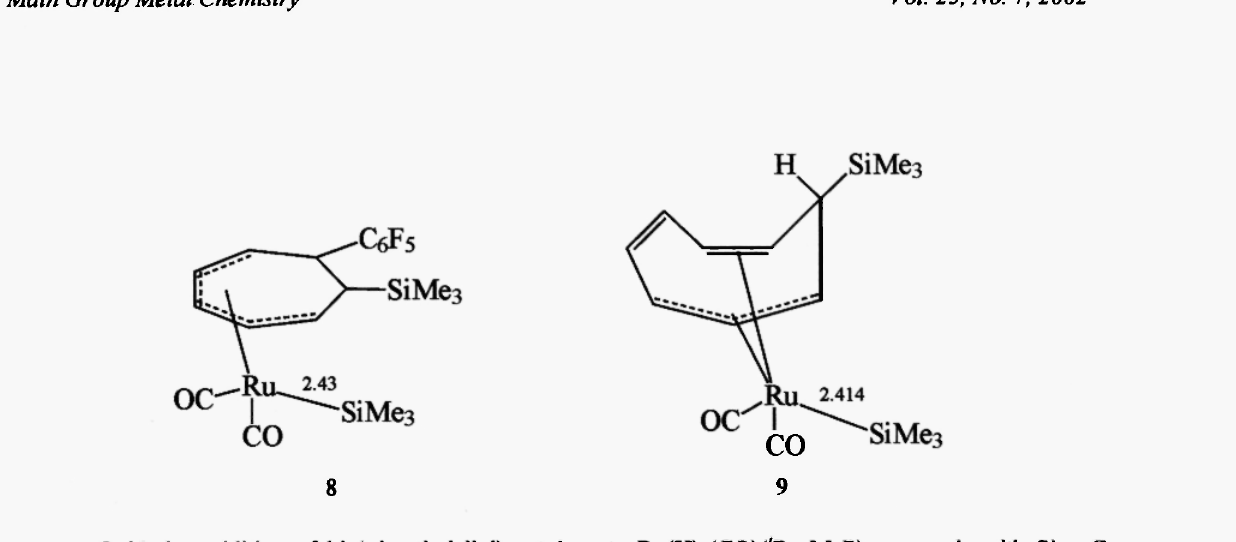
CO 9 Oxidative addition of bis(trimethylsilyl)acetylene to Ru(H) 2 (CO)('Bu 2 MeP) 2 proceeds with Si - C bond cleavage and addition of both Si and C atoms to the ruthenium center. The crystal structure of this product 10 indicates that the ruthenium atom has a square-pyramidal coordination with trans phosphine ligands. The silyl group occupies an apical position while the trimethylsilylethynyl substituent is in a basal site and trans to CO ligand [18]. The most unusual feature of the structure is the acute SiRuC(CSiMe 3 ) angle, 80 .2°. Me Si 3 2.382